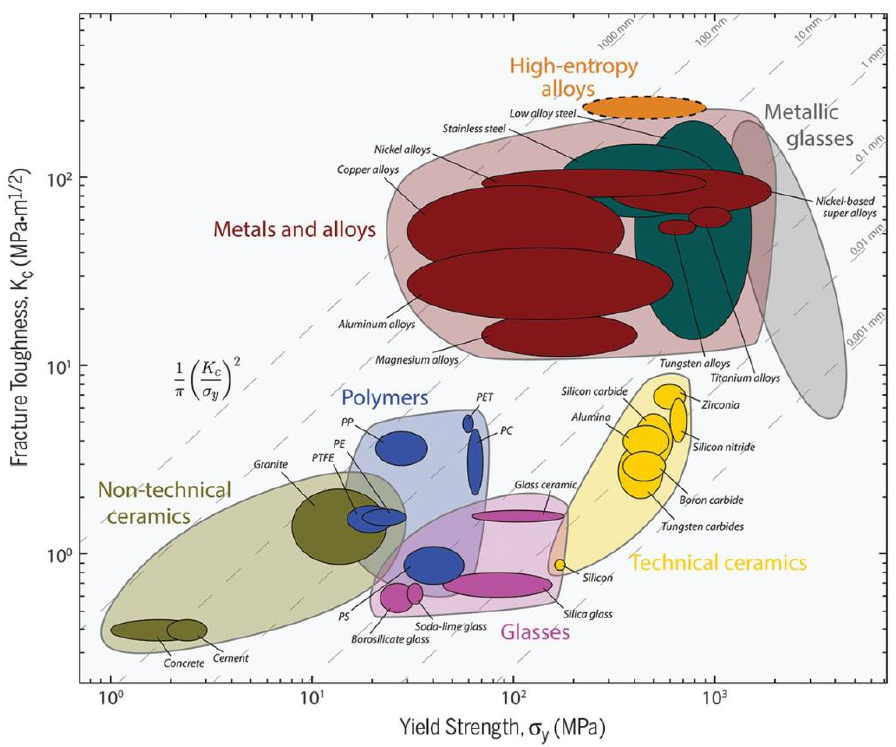
Figure 2. An Ashby plot that compares the fracture toughness and yield strength of HEAs with several other materials and bulk metallic glasses (reproduced from Reference [46] with permission). Metals 2020 , 10 , x FOR PEER REVIEW